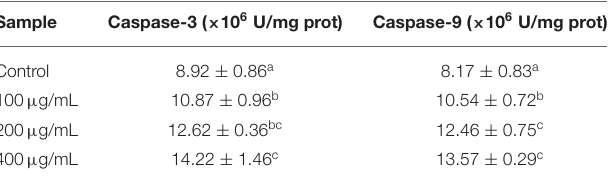
TABLE 3 | Caspase-3 and caspase-9 activity of HepG2 cell after PSP-1 treatment.